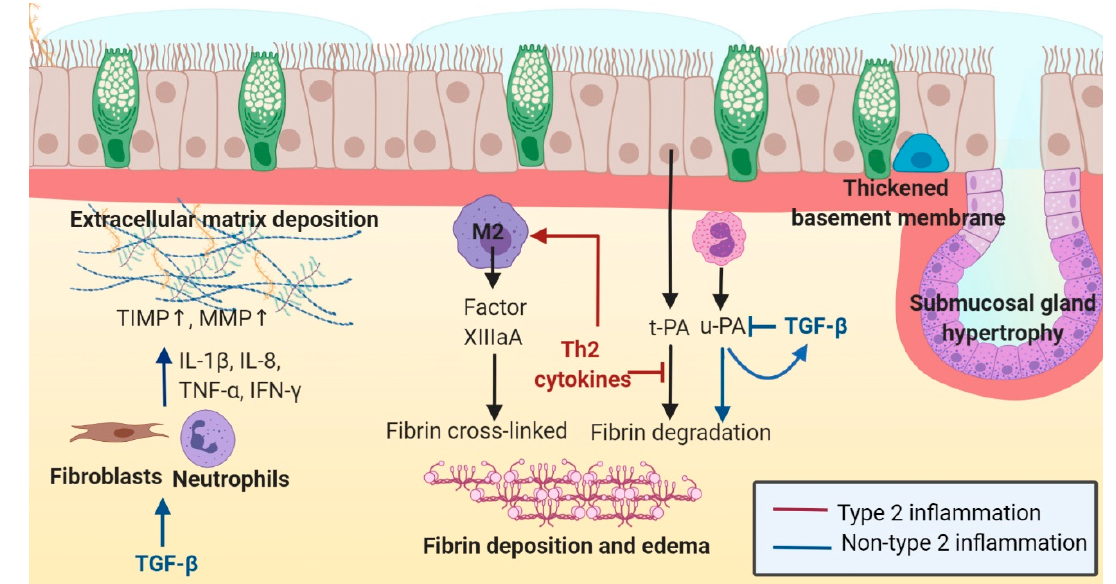
Figure 2. Subepithelial remodeling (extracellular matrix deposition, fibrin deposition, basement membrane thickening, and submucosal hypertrophy) according to the type of inflammation in chronic rhinosinusitis.